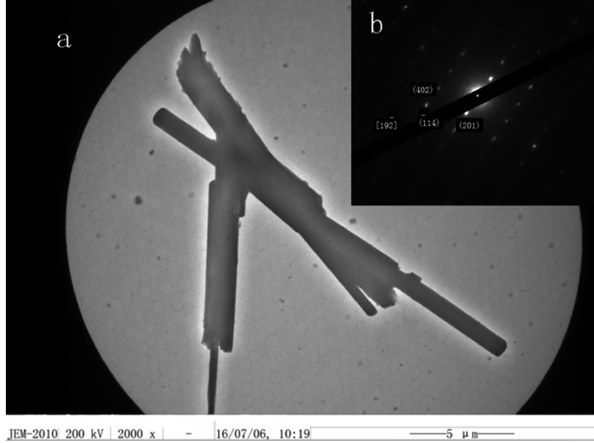
Figure 5: TEM images of K 2 Ti 4 O 9 whiskers incinerated at 1050°C.